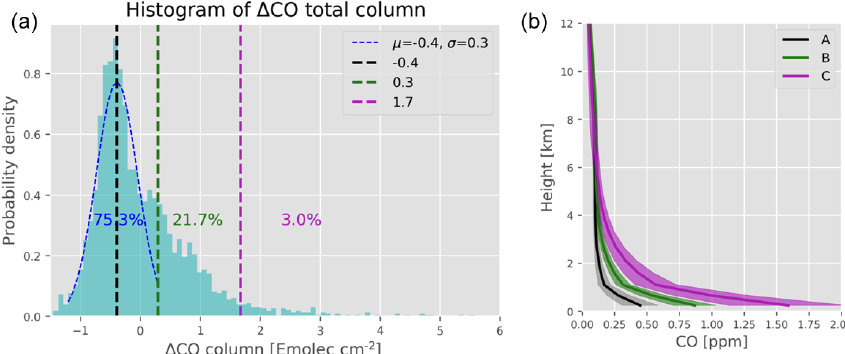
Figure 8. (a) The frequency density of the FTIR (cid:49) CO distribution. Based on the highest density, we apply a normal distribution fitting ( µ = − 0 . 4 and σ = 0 . 3). The (cid:49) CO values that are less than µ + 2 σ , between µ + 2 σ and µ + 6 σ , and larger than µ + 6 σ are labeled as categories A (background), B, and C, respectively. The percentages of the categories A, B, and C are also indicated in the figure. (b) The vertical profiles of CO mole fraction within the three categories.